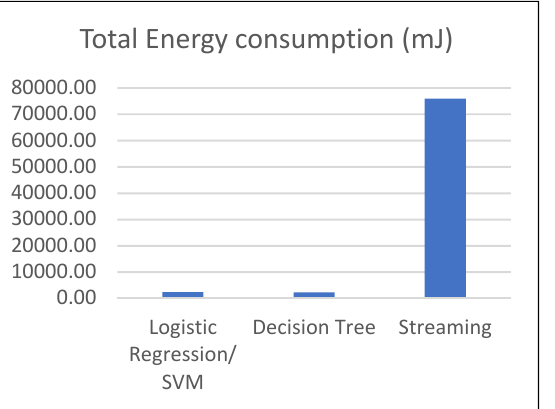
Figure 7. Total energy consumption results in our scheme compared with the streaming scenario.